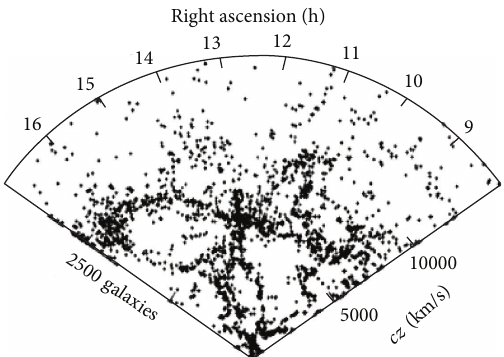
Figure 1: The web-like spatial distribution of galaxies reported by Geller and Huchra [8].